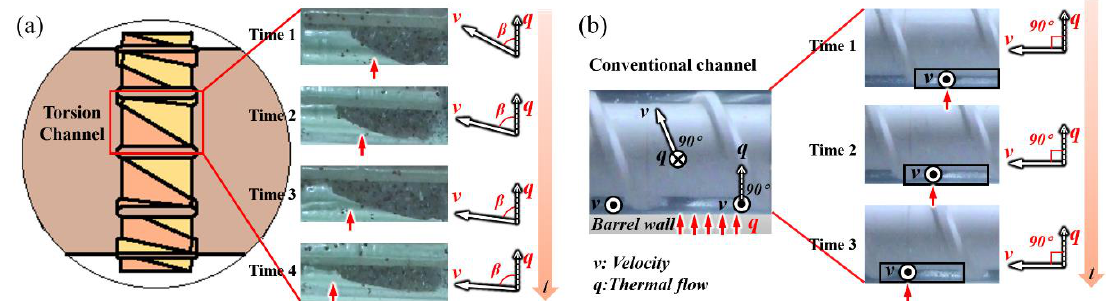
Figure 9. Flow patterns of fluids in the TOEs and STDs channels at different times: ( a ) TOE channel; ( b ) STD channel.